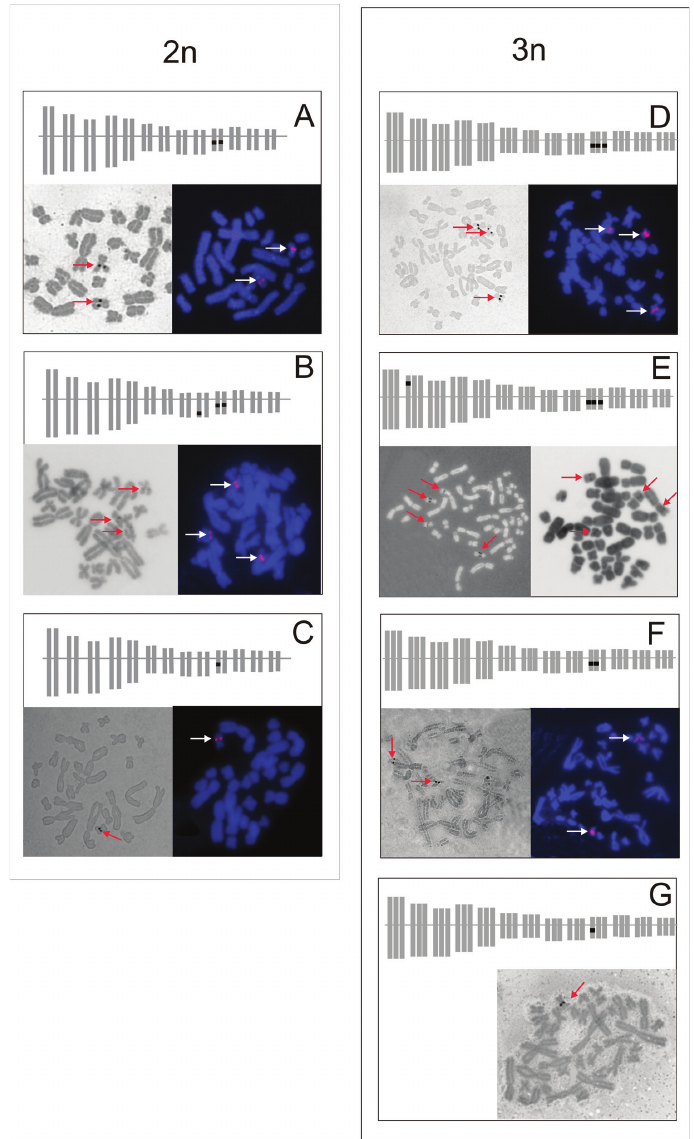
Figure 2. Localization and number of NORs (arrows) in diploid and triploid water frogs. Left column represent diploids ( A–C ) and right column represent triploids ( D–G ). Each picture is composed of a diagram of karyotype with black dots representing NORs and metaphase plates stained with silver (Ag- NOR), chromamycin A (CMA ), propidium iodide after denaturation (DPI) or after fluorescent in situ 3 3 hybridization with 28S rDNA probe (FISH). A P. lessonae LL with 2 NORs, AgNORs (left) and FISH (right) B P. esculentus RL with 4 NORs on chromosome 9, CMA (left) and FISH (right) C P. esculentus 3 RL with 1 NOR, AgNORs (left) and FISH (right) D P. esculentus LLR with 3 NORs, AgNORs (left) and FISH (right) E P. esculentus RRL with 4 NORs, AgNOR (left) and DPI (right) F P. esculentus RRL with 2 NORs, AgNORs (left) and FISH (right) G P. esculentus RRL with 1 NOR, CMA 3